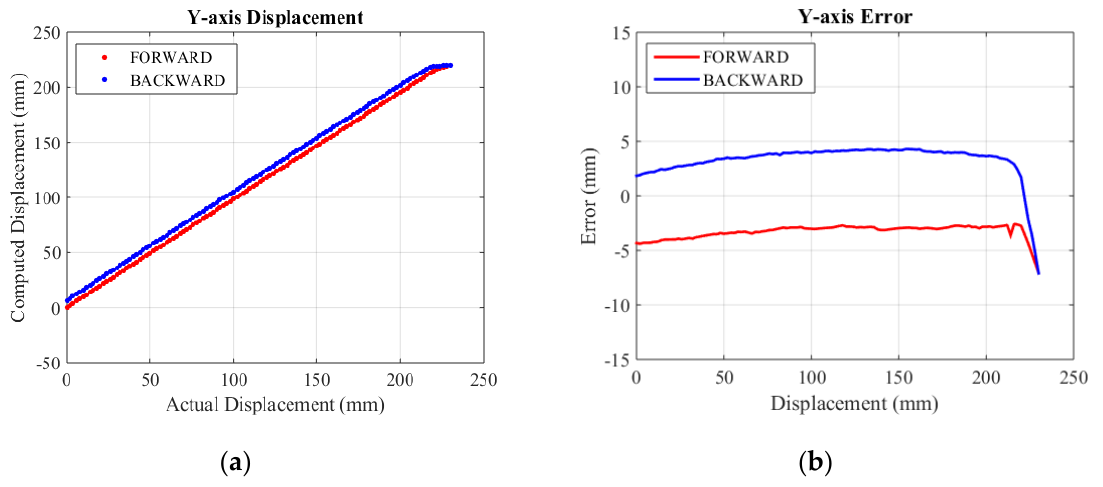
Figure 14. Y-axis displacement and error. ( a ) Displacement ; ( b ) Error.